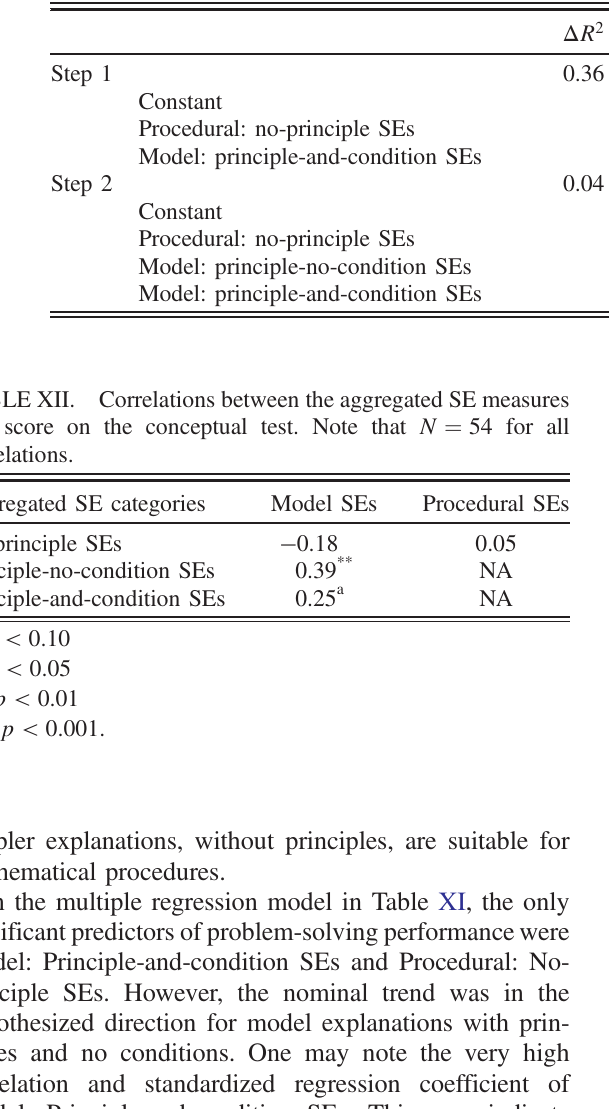
TABLE XI. Hierarchical regression of aggregated SE categories as predictors of post-test problem-solving score. Note that N ¼ 54 .